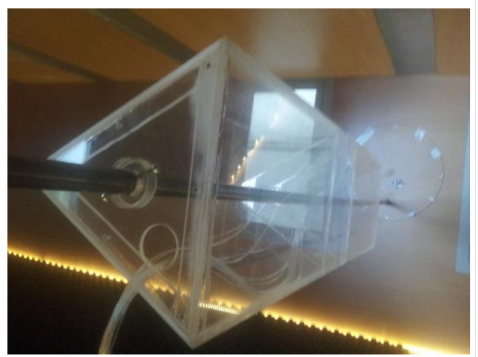
Figure 3. Model of building under examination inside the wind tunnel.